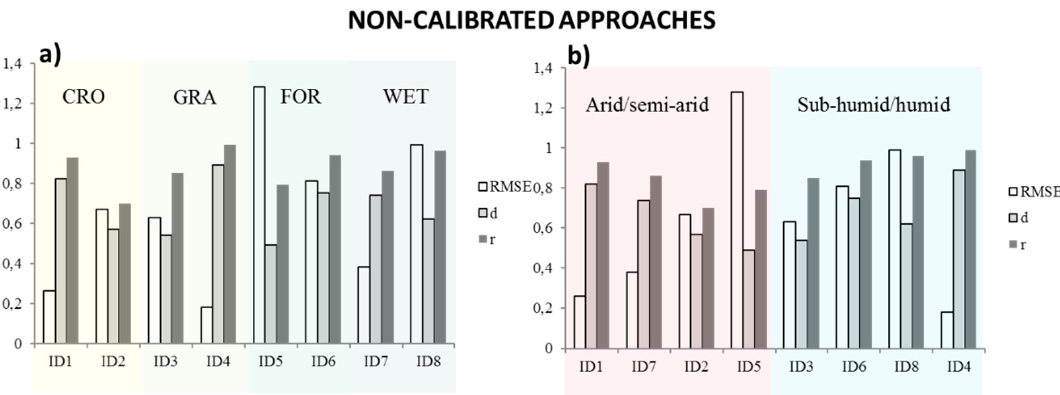
Figure 4. Goodness-of-fit indices for the most accurate model and for all the sites in case of non-calibrated approaches. Reference is made to ( a ) land cover (CRO, GRA, FOR, WET that respectively stand for cropland, grassland, forest, and wetland) and to ( b ) the moisture index I M (arid/semi-arid versus sub-humid/humid, ID numbers are sorted for increasing I M ). Table 6. The RMSEd for the modelled Rn and Gsoil variables.